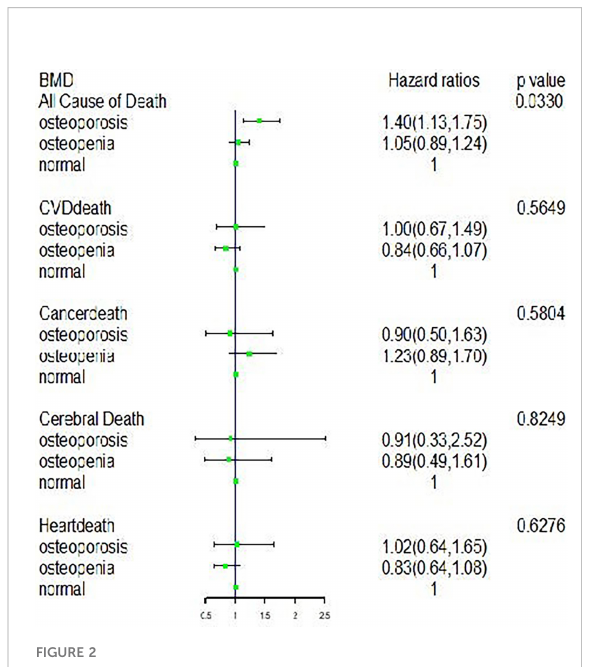
FIGURE 2 The forest plot about hazard ratios (95% CI) for CVD, cancer and all-cause